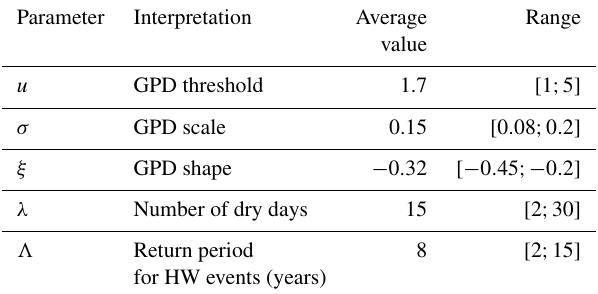
Table 1. Parameter value ranges for the damage function S ( t ) ob- tained from the drought–heatwave (HW) index I YV values com- puted for the five stations. The average GPD threshold is the average of the 95th quantiles of the index for the five stations. The average GPD scale and shape parameters are the averages of the estimates for the indices for each of the five stations. The ranges of the GPD parameters take uncertainties into